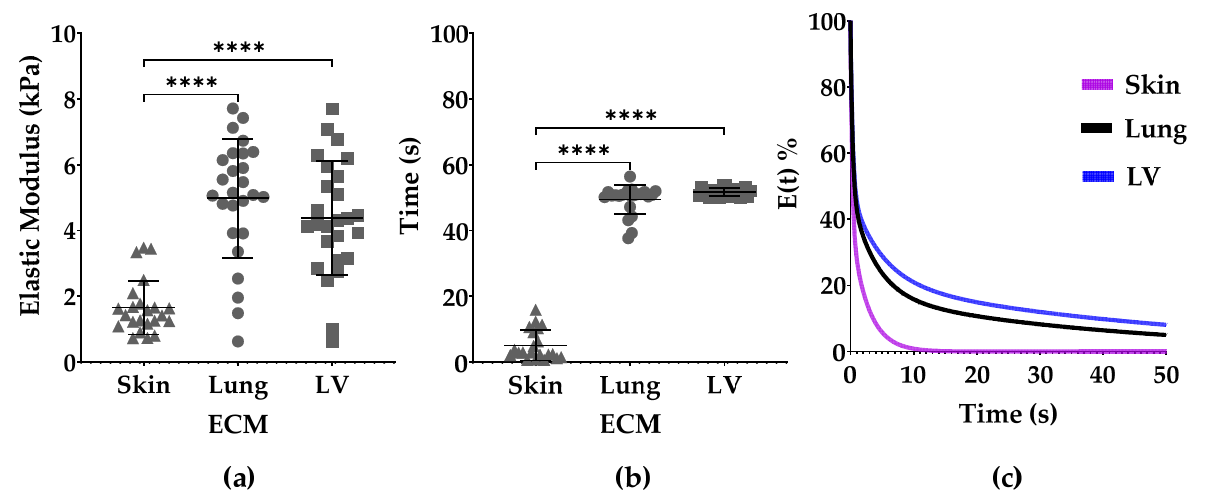
Figure 3. Viscoelastic properties of skin-ECM, lung-ECM and LV-ECM. ( a ) Elastic modulus; ( b ) Time to reach 50% stress relaxation; ( c ) Average stress relaxation normalized to start from 100%. All data derived from a minimum of three independent experiments performed in triplicates from low-load compression testing at 0.2 strain. Data are presented as mean with SD. Statistical differences according to one-way ANOVA and Dunn’s post hoc test **** p < 0.0001.